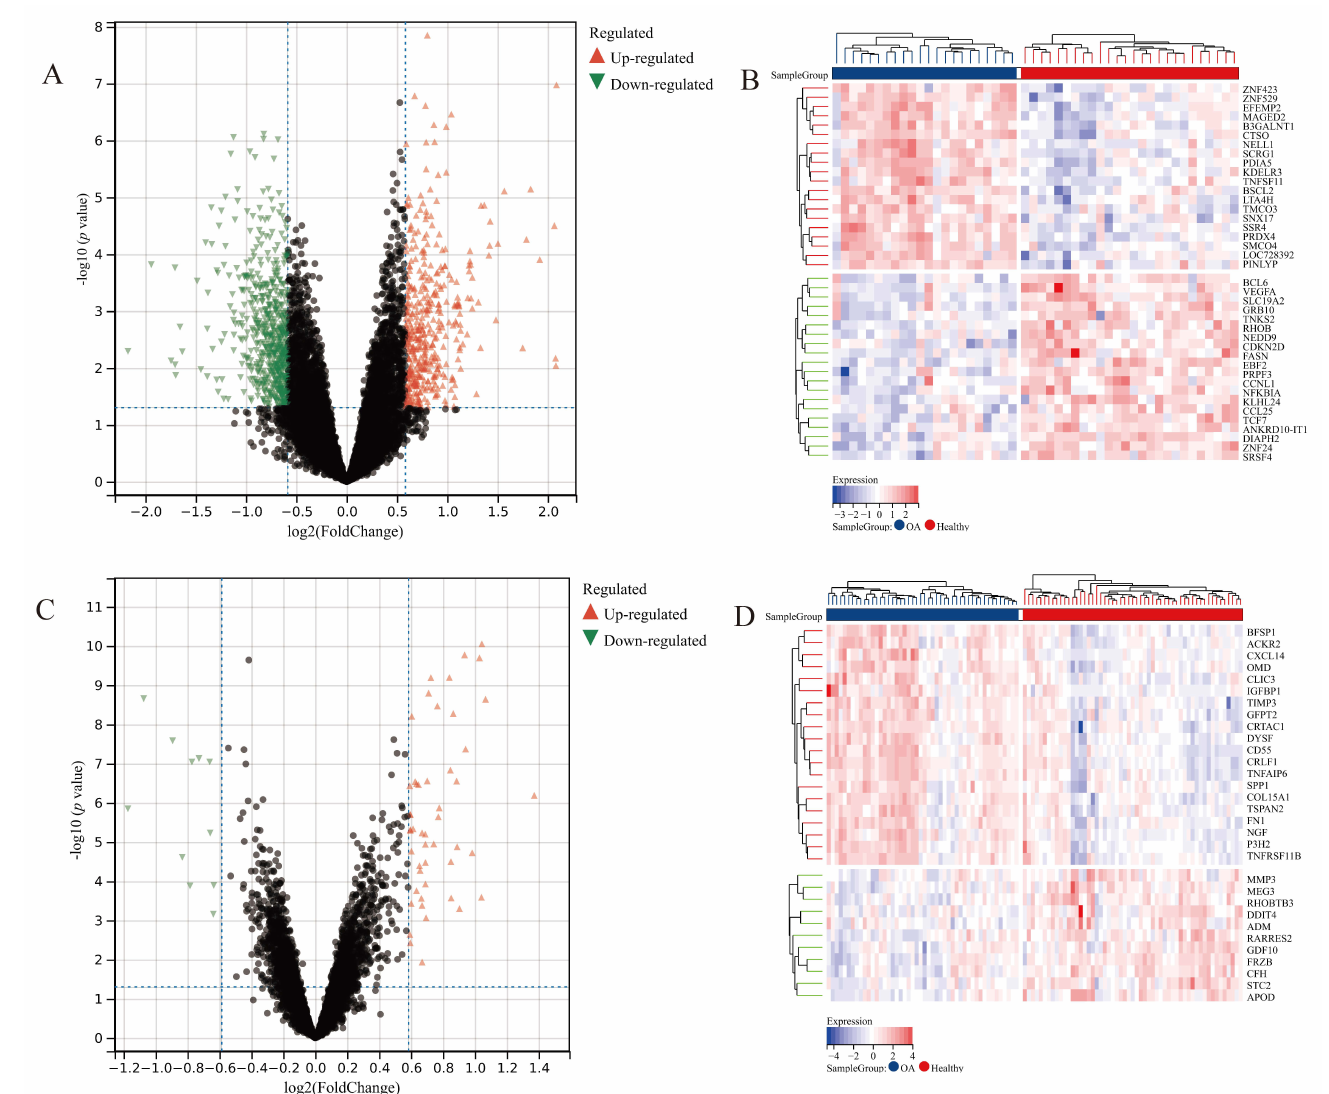
Figure 2. Differentially expressed gene analysis: volcano plot of the synovium dataset, ( A ); heat map of the synovium dataset, ( B ); volcano plot of the cartilage dataset, ( C ); and heat map of the cartilage dataset, ( D